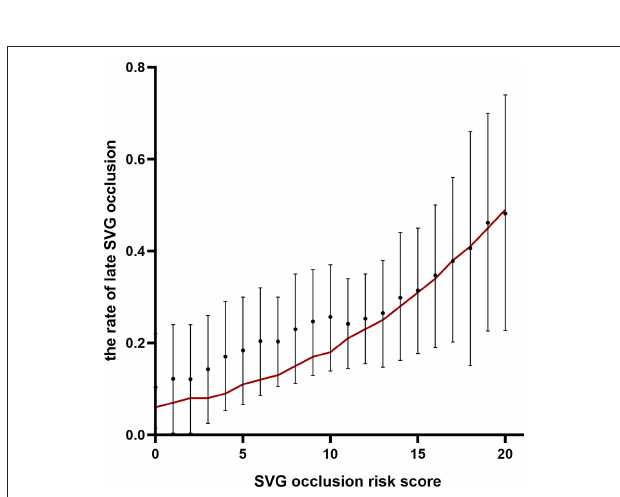
FIGURE 2 | Observed rate of occlusion with 95% confidence interval vs. model-predicted risk of occlusion in groups based on the developed risk score. SVG, saphenous vein